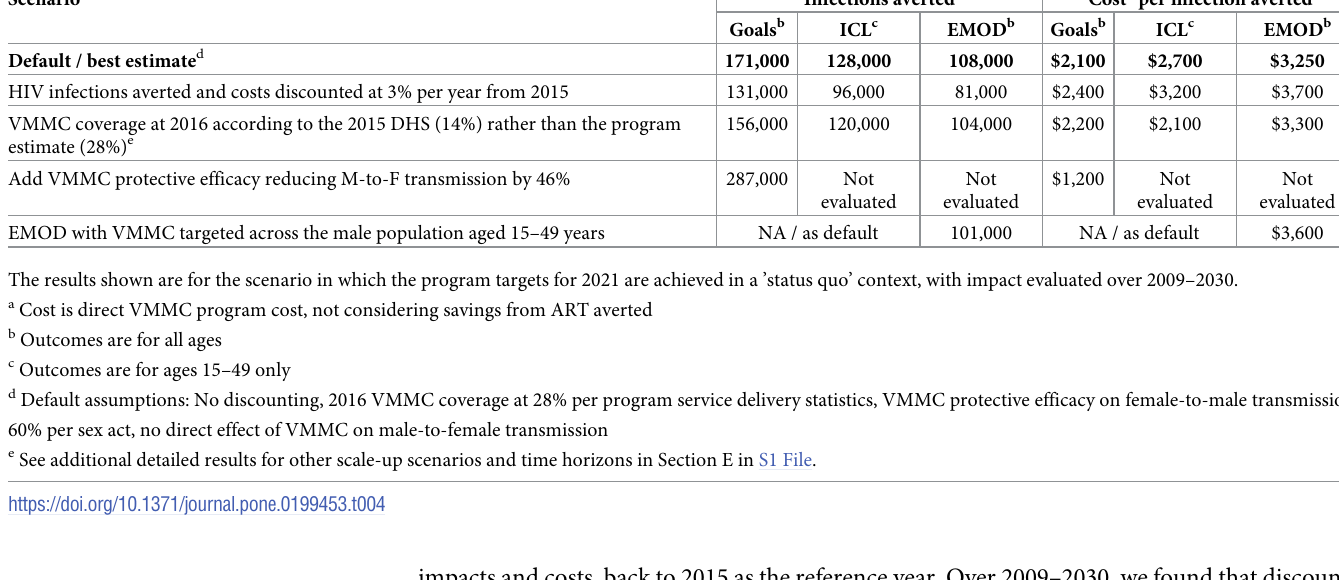
Table 4. Sensitivity analyses. Impact and cost-effectiveness of Zimbabwe’s VMMC program under alternative assumptions for key parameters whose values are uncertain.